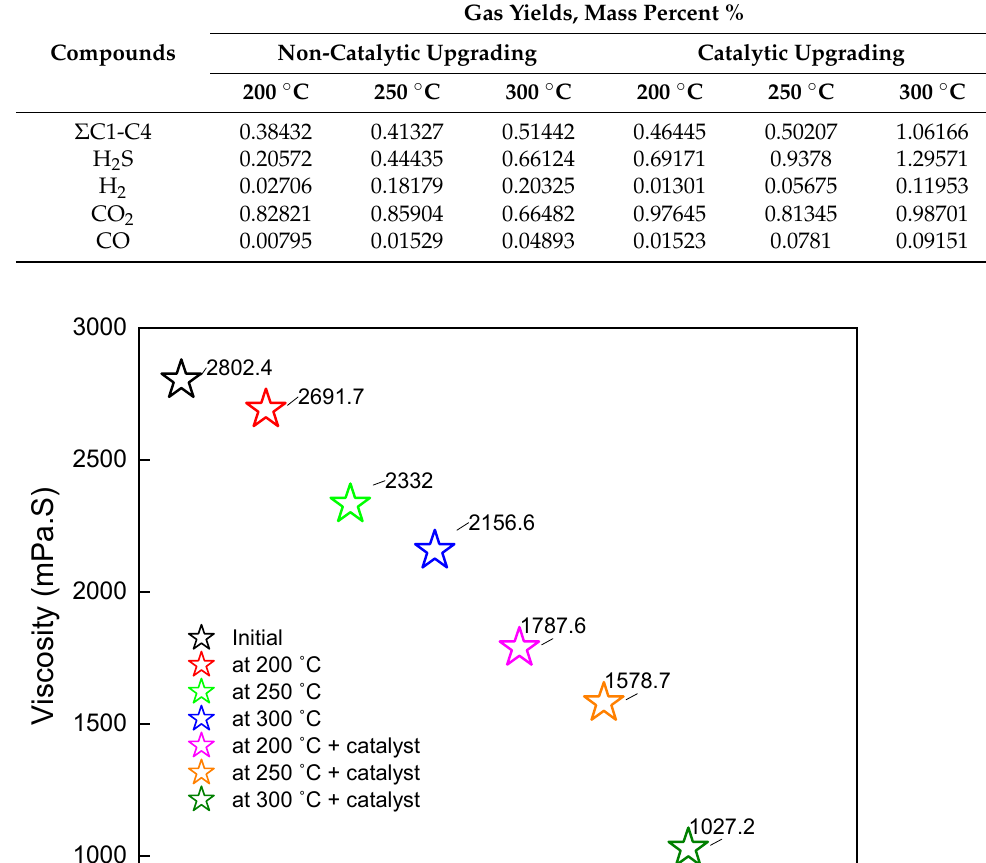
Table 2. Evolved gas products during heavy oil upgrading in the presence and absence of MoOHC.